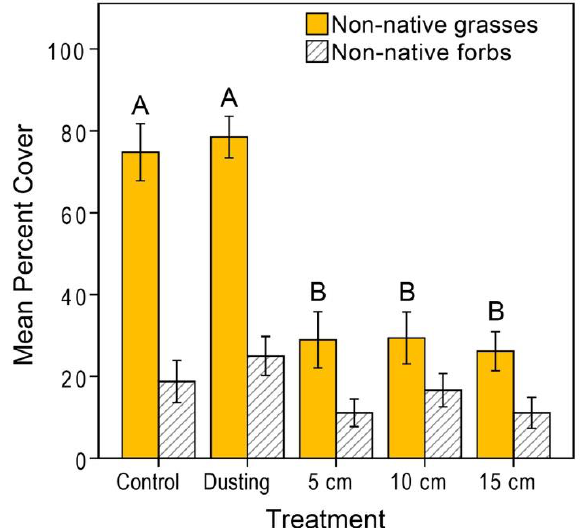
Figure 3. Average total seeds (in seeds / mL of soil) collected at the salvaged donor site, at various depths. A significant number of seeds was found in the top 5 cm of soil. Bars represent +/ − 1SE of the mean. (Kruskal–Wallis—Chi-square = 9.374, df = 3, p = 0.025.)